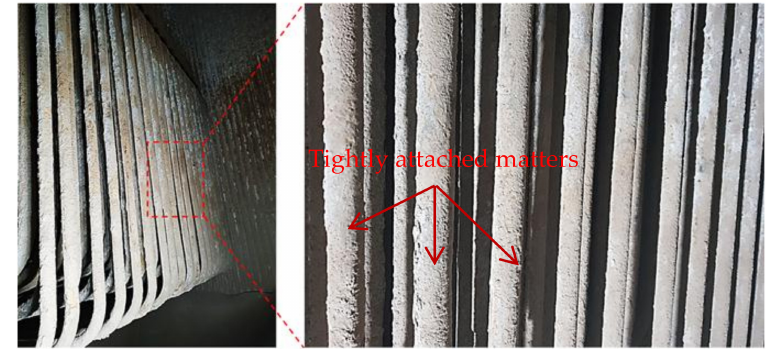
Figure 12. Photography of the uncoated areas of the boiler